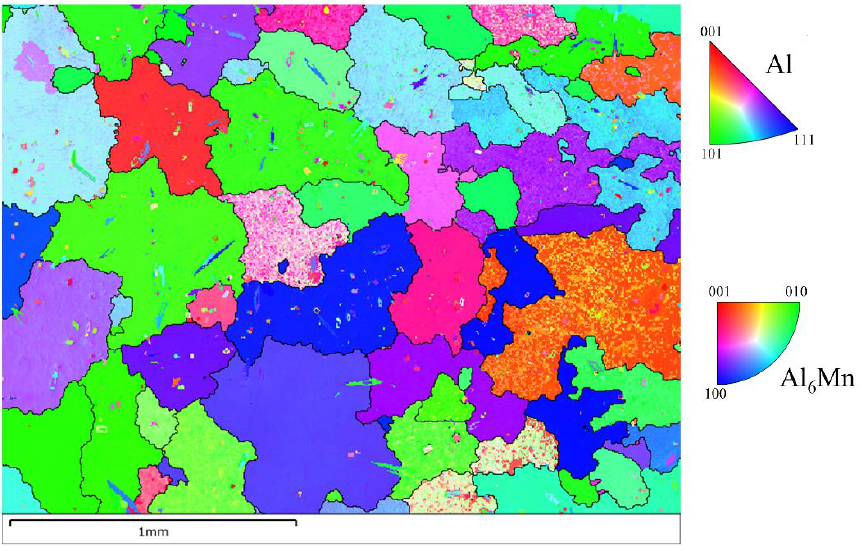
Figure 4. Orientation map analyzed with EBSD where black line indicates grain tolerance angle over 5 degrees. Table 2. EDS point and linescan data from Figure 3b. x denotes the site fraction of Mn in Al 6 (Mn x ,Fe 1−x ) precipitate.